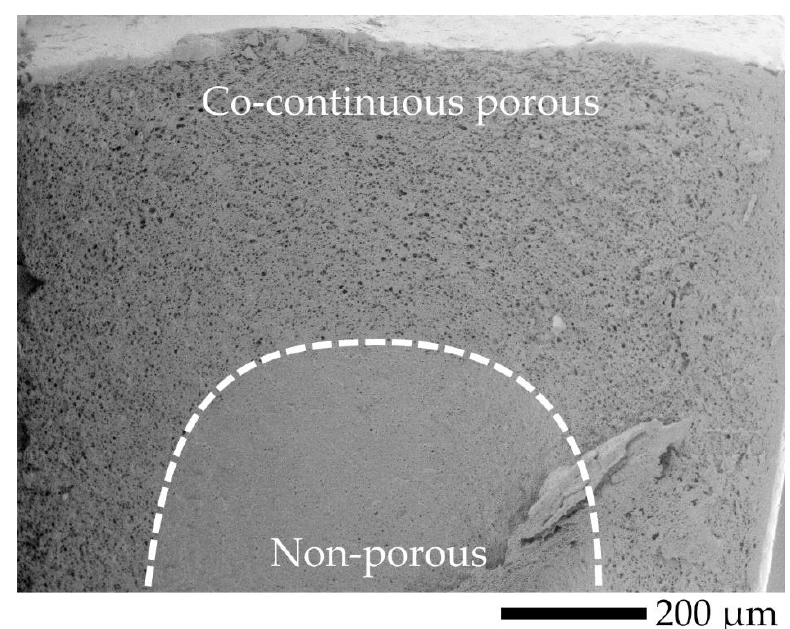
Figure 9. SEM micrograph observed at (III) location of L5V5 in TD at etching time of 1 day.